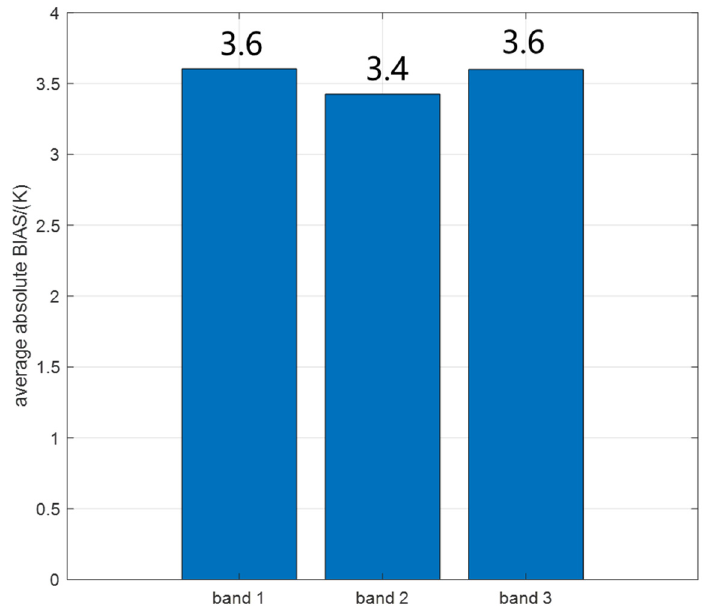
Figure 16. The mean absolute bias between retrieved temperature and actual temperature through different bands.